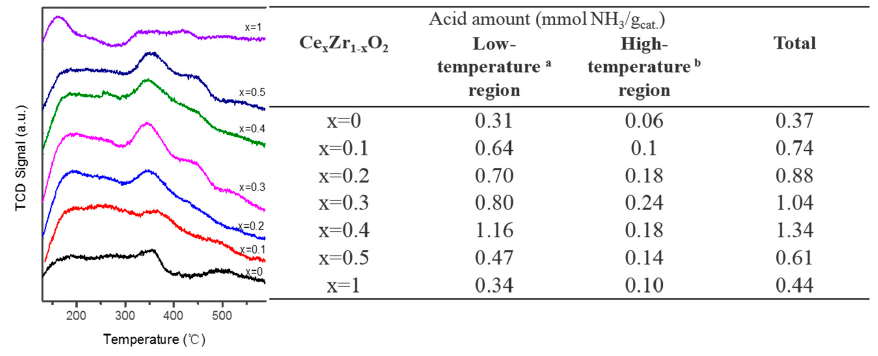
Figure 3. The NH 3 -TPD patterns and the calculated acid amounts of Ce x Zr 1 − x O 2.